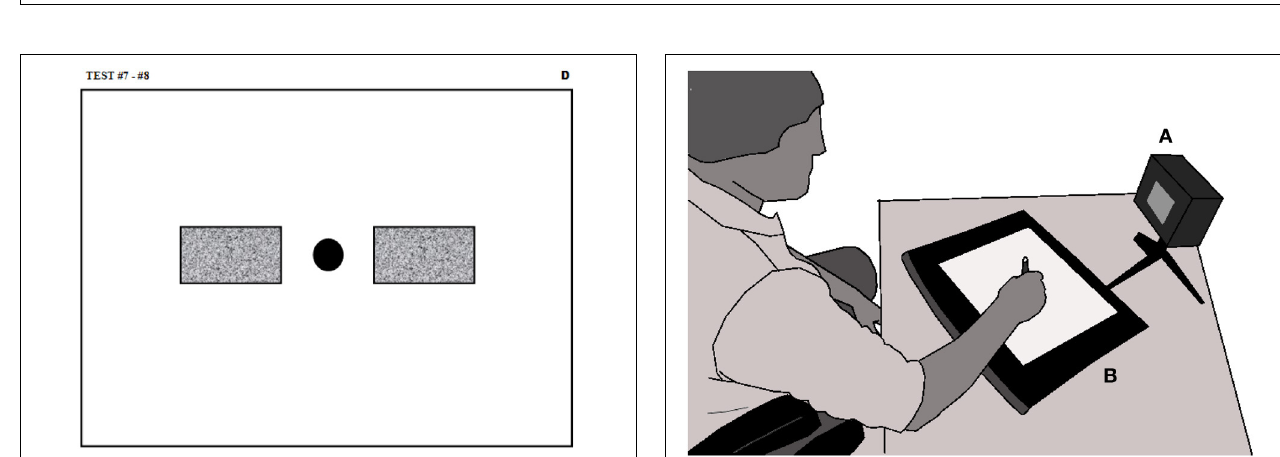
FIGURE 6 | Guiding sheets for the fast pen stroke sequence test. The black circles indicate the starting and the gray circles specify the target zones that have to be crossed prior to coming back to the black dots.